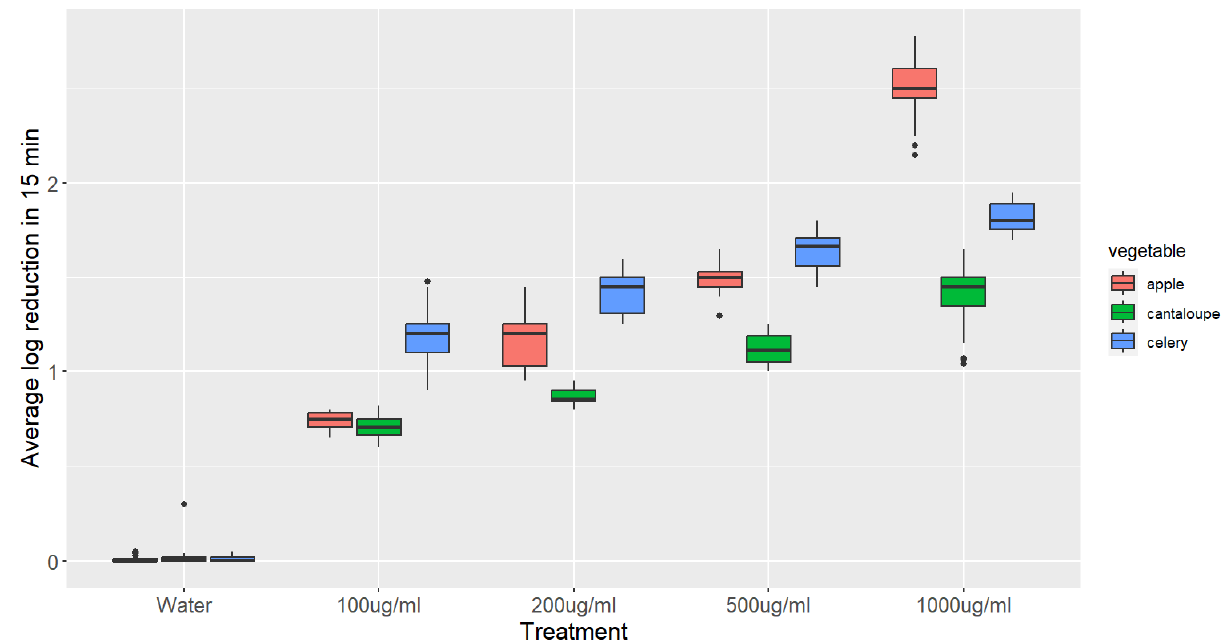
Figure 2. Boxplots showing the reduction of L. monocytogenes on different vegetables after 15 min treatment with various concentrations of GSE. The log reduction values were compared using an ANOVA, followed by a Tukey’s post hoc test. The boxplots represent the distribution of log reduction values for each treatment and vegetable, with the median, interquartile range, and range of values. The statistical analysis revealed that all of the log reductions were significantly higher than the control ( p -value < 0.05), and the log reduction in the 1000 µ g/mL treatment of apple was significantly higher than those in all other treatments ( p -value < 0.05).